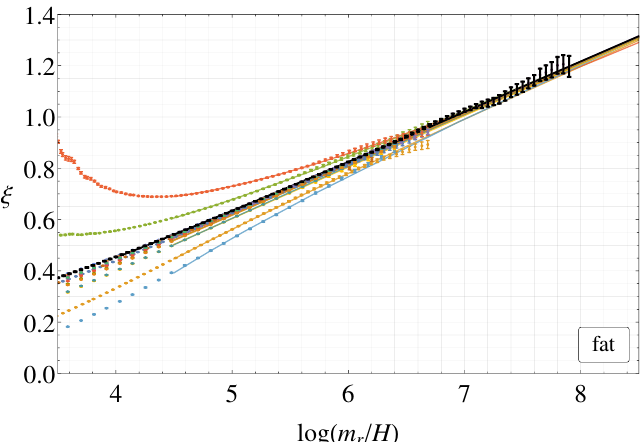
Figure 6: The evolution of the density of the fat string network, ξ , starting from different initial conditions, with statistical error bars. The convergence towards a common attractor solution, and the logarithmic growth of ξ on this, are manifest. The best fit lines with the form eq. (3) are also shown. We identify the initial condi- tions used for the analysis of the spectrum of axions in